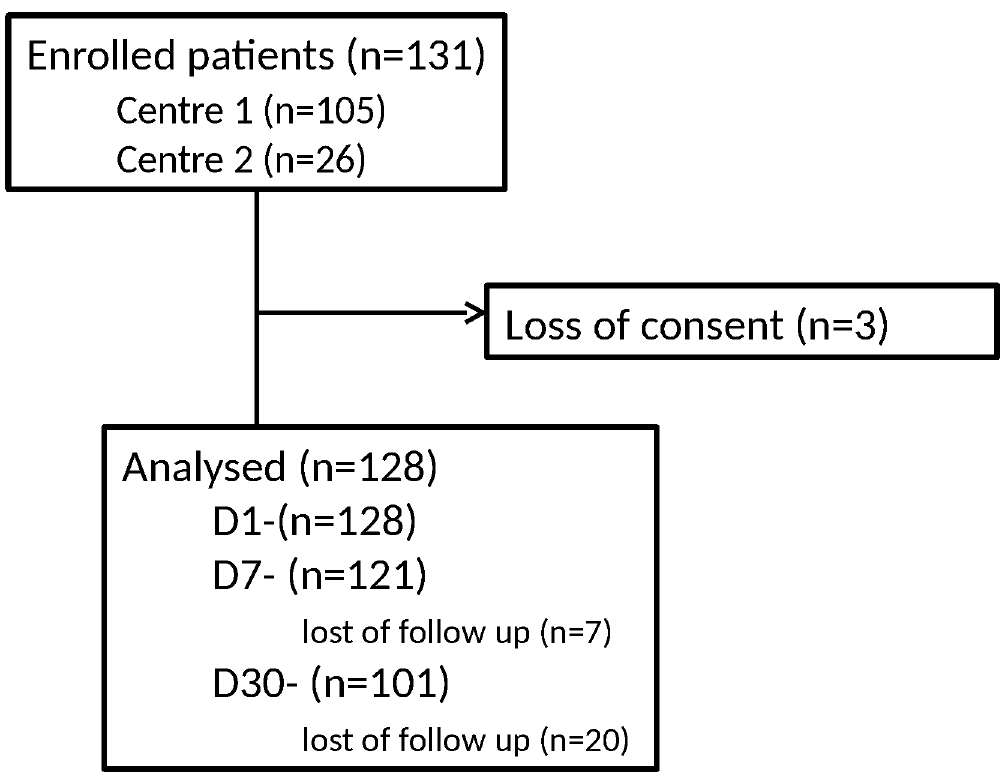
Fig 1. Flow chart.